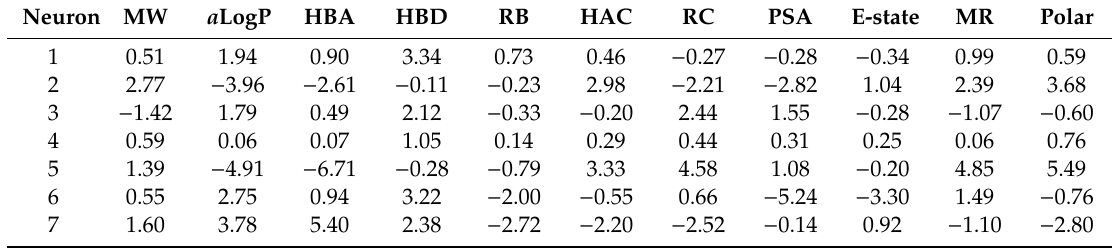
Table 4. Weights attributed to each physicochemical descriptor at the individual hidden-layer neurons. Neuron MW